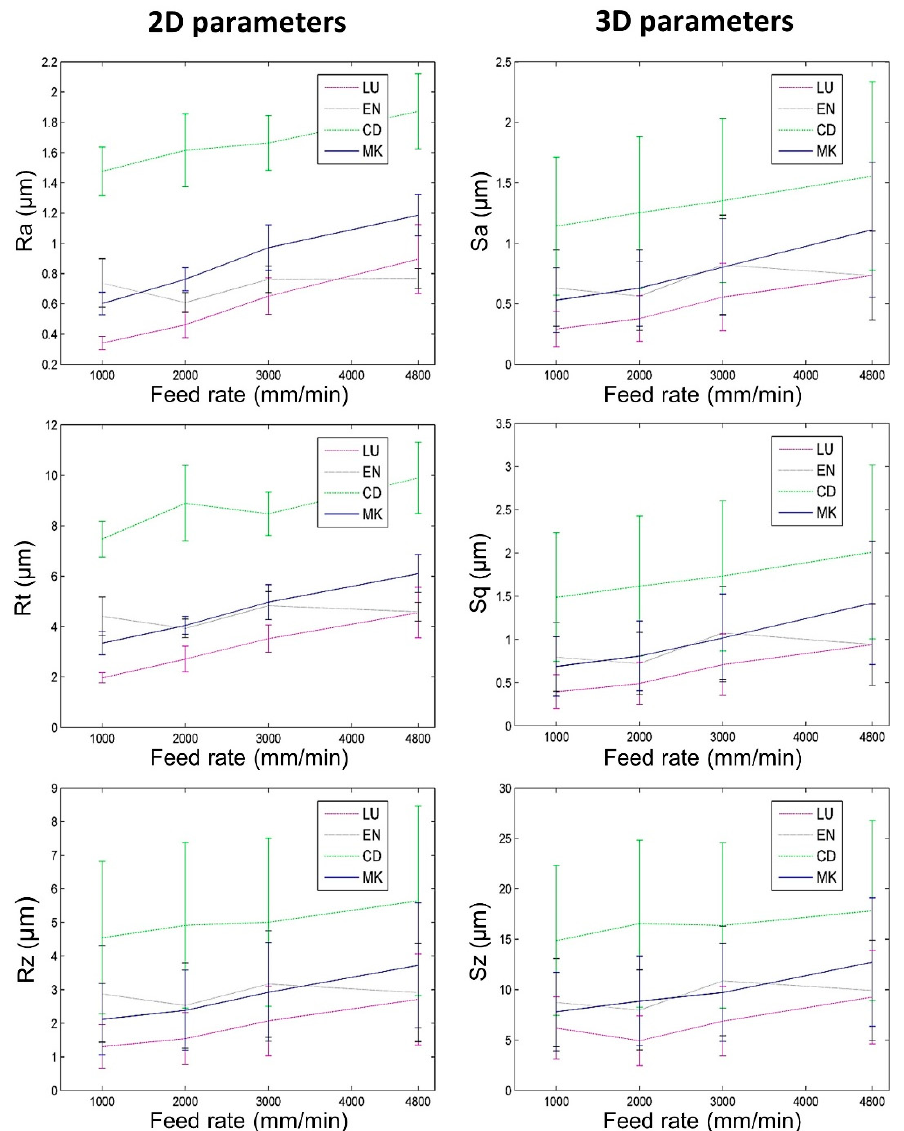
Figure 5. Roughness depending on prosthetic material and feed rates when milling with the Lyra tool (vertical bars represent standard deviation).